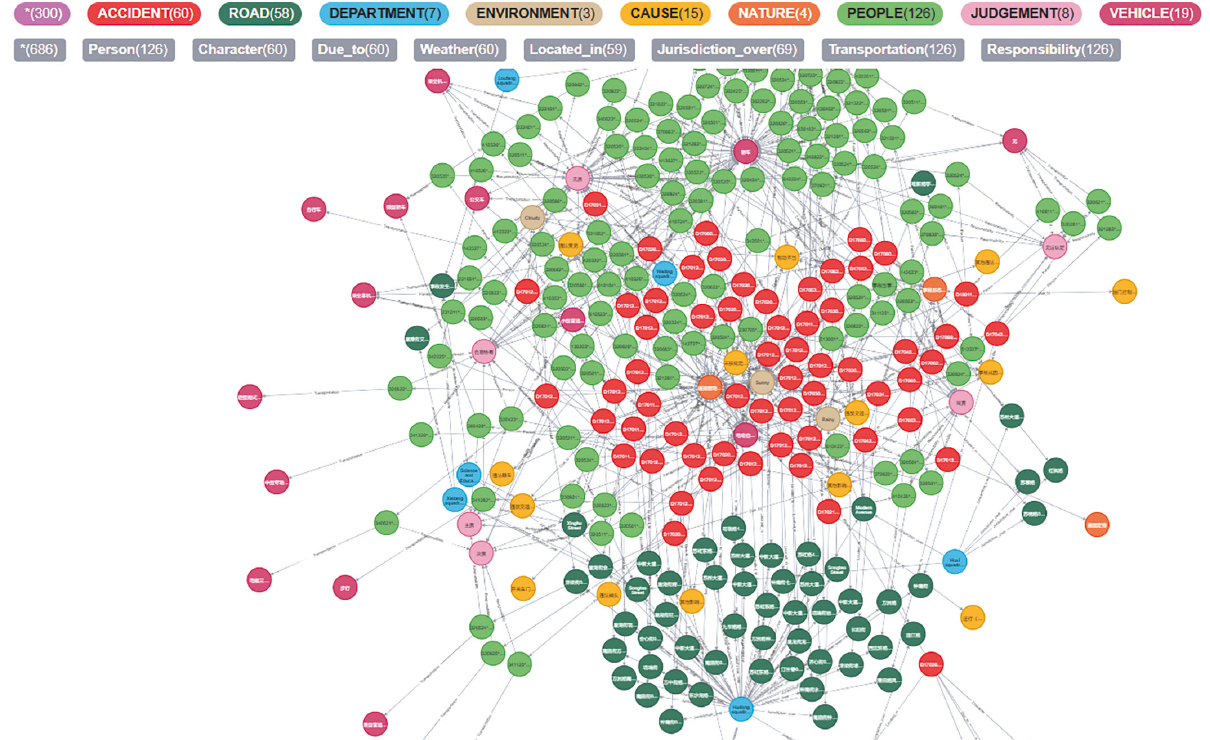
Figure 6: Visualized map of traffic accident knowledge.